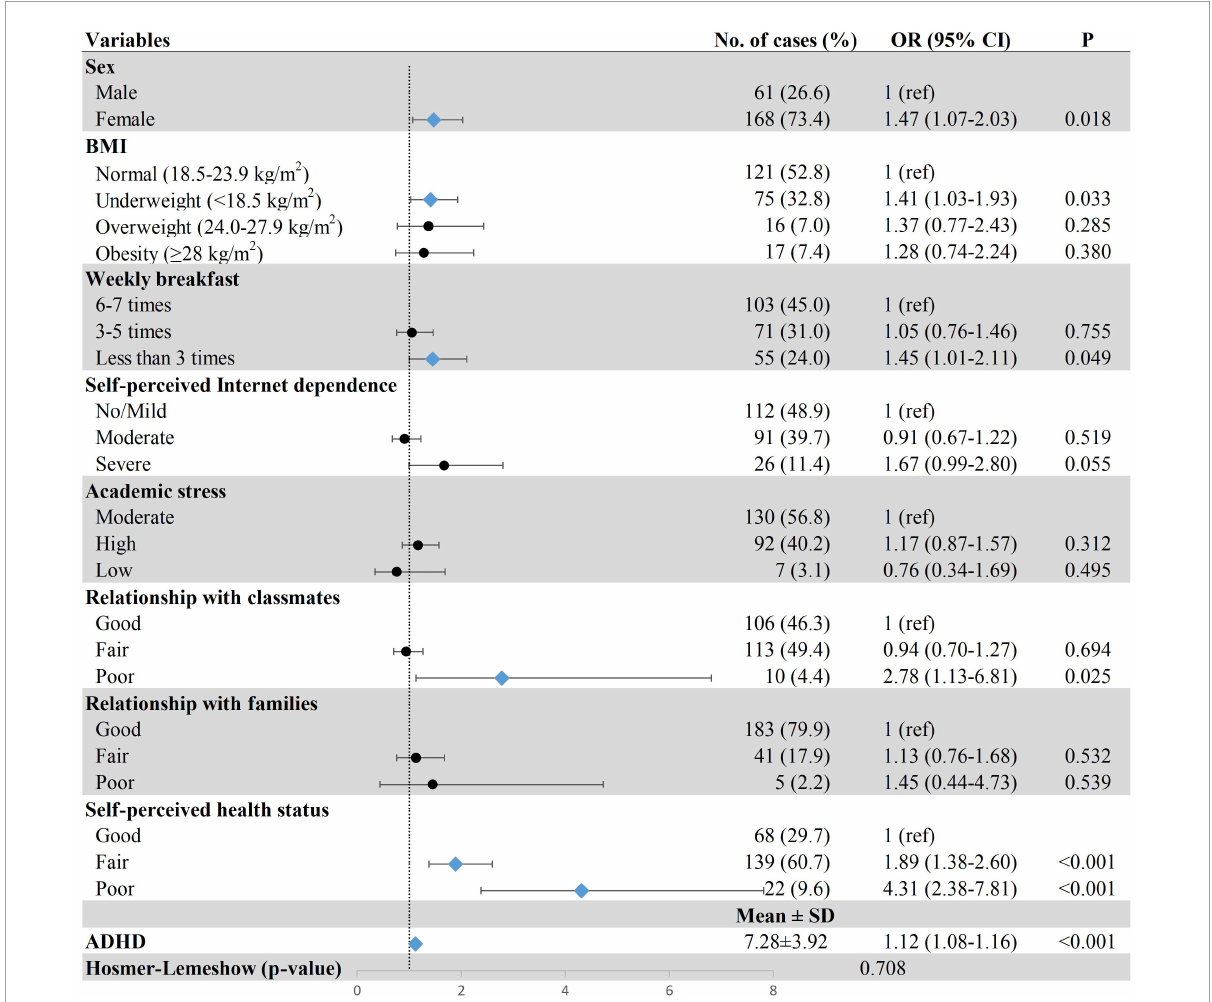
FIGURE3 Associations between demographic and clinical characteristics and DMS. Row with blue diamond indicates statistical significance. ADHD, attention-deficit/hyperactivity disorder; BMI, body mass index; DMS, difficulties in maintaining sleep; OR, odds ratio; 95% CI, 95% confidence